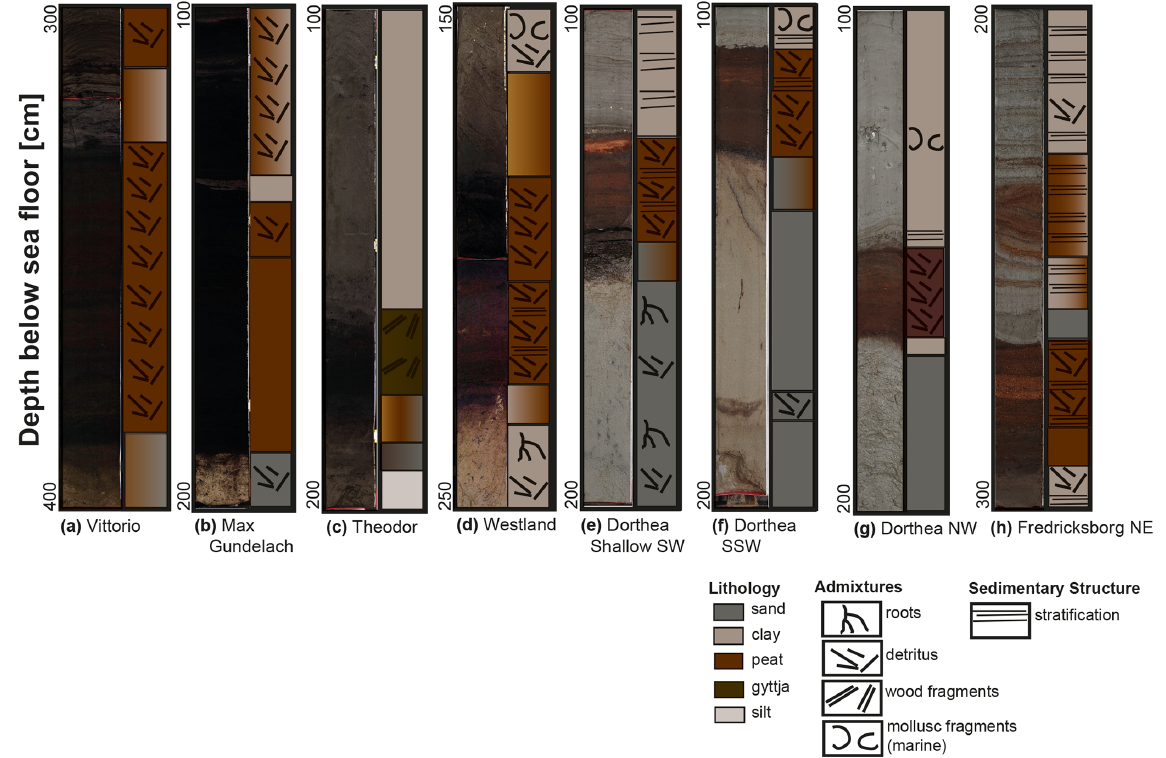
Figure 2. Photographs and stratigraphy of key sites. (a–d) The four sites from which sediments were used to perform 16S rRNA gene-based diversity analysis. These sites lie within the middle and southern North Sea. (e–f) The four sites from which sediment was used to study microbial activity. These sites originate from the Dogger Bank area. Note the varying y axes. Table 1. Radiocarbon dates. The 14 C dates of the Max Gundelach site in the Vlieland area and the Fredricksborg NE site in the Dogger Bank area, the two sites where plant macrofossil analysis was